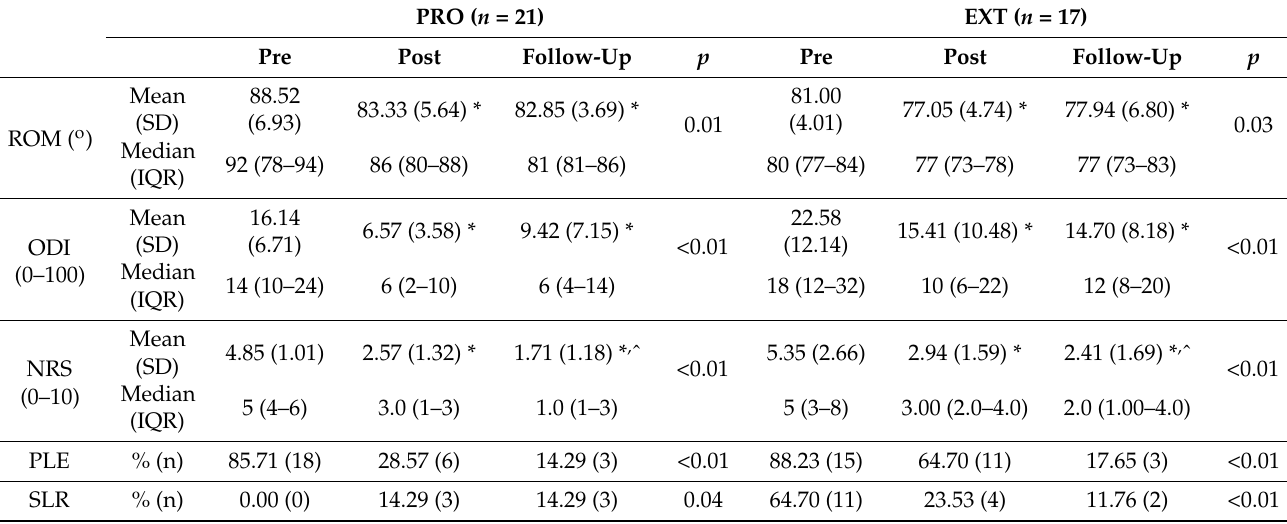
Table 2. Changes of the clinical outcomes after the